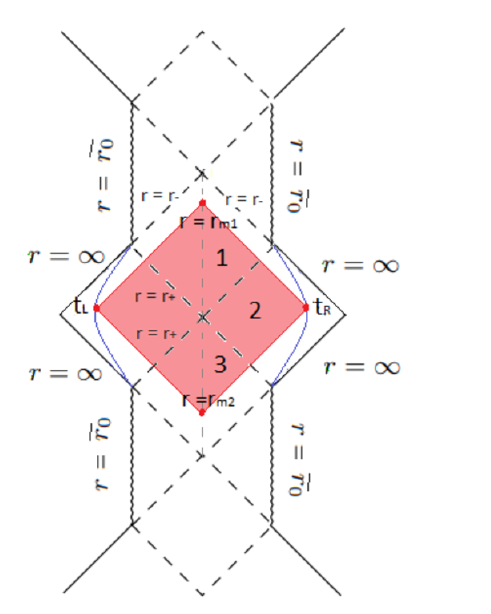
Figure 6 . Penrose diagram for the WDW patch in the rotating